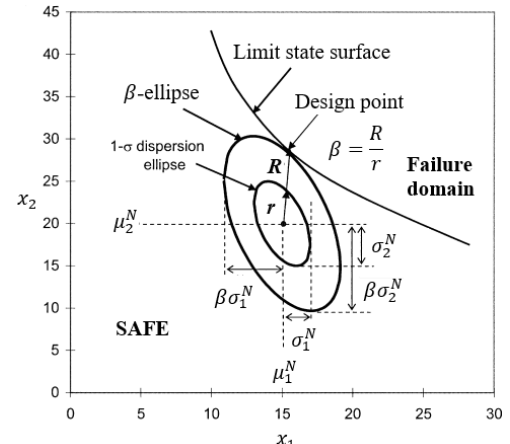
Figure 1. Equivalent dispersion ellipsoids illustrated in the plane